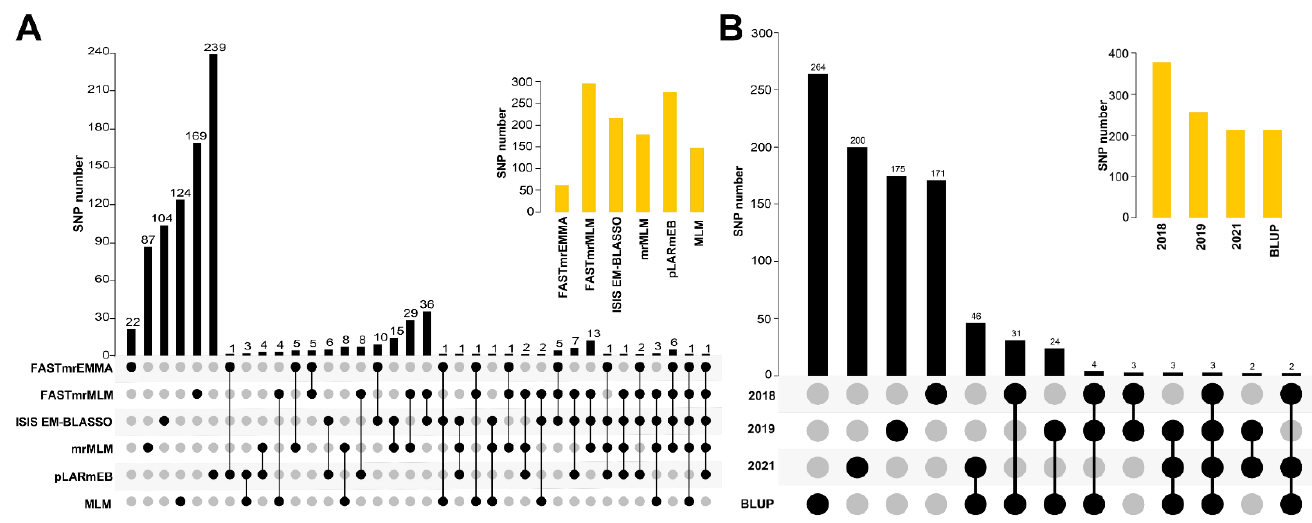
Figure 2. Distribution of SNPs identified in different environments and algorithms. ( A ) Veen of significant SNPs detected by different algorithms. Here, the SNPs detected for a certain trait (without distinguishing the environments) by different algorithms are regarded as one SNP. Upper right displays distribution of SNPs identified by different algorithms. ( B ) Veen of significant SNPs detected by different environments. The SNPs detected for a certain trait in different environments (without distinguishing the algorithms) are regarded as one SNP. Upper right displays distribution of SNPs identified in different environments.